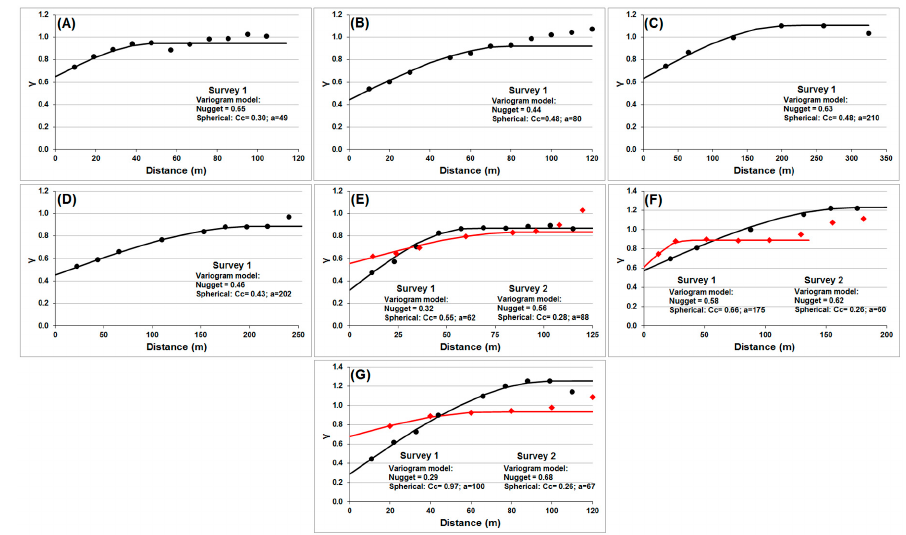
Figure 5. Experimental and modeled variograms for the CO 2 flux normal scores using the different datasets: ( A ) Caldeirão West; ( B ) Caldeirão East; ( C ) Negra; ( D ) Funda; ( E ) Comprida; ( F ) Rasa; and ( G ) Lomba lakes during the first (red) and second (black) surveys. Values for Cc (sill) and range (a; in m) are also shown for each variogram.